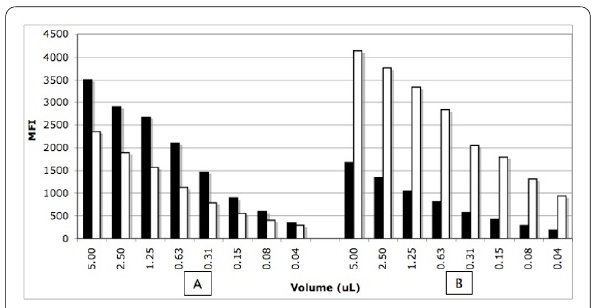
Figure 2 Effect of the DNA concentration of the kinetic of hybrid- ization . Panel A; homozygous wild type DNA, panel B: homozygous mutated DNA. Black bars correspond to the wild type probe (V617Fwt) and white bars correspond to mutated probe (V617Fmut). MFI: median fluorescent intensity.